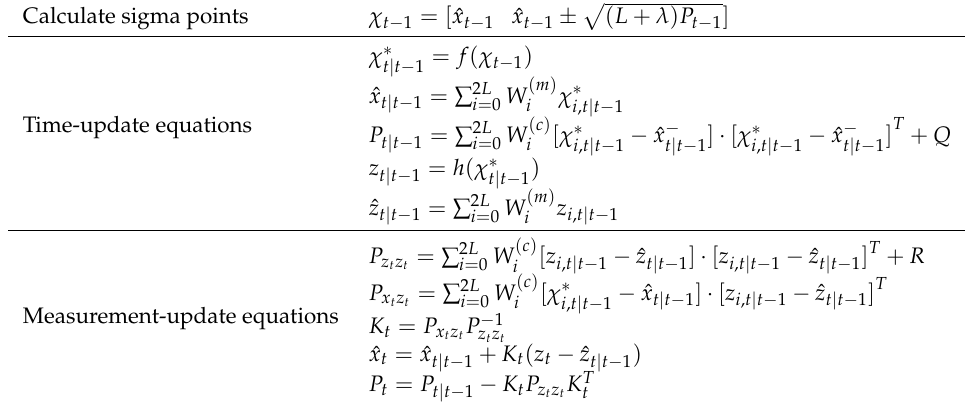
Table 1. Unscented Kalman filter.